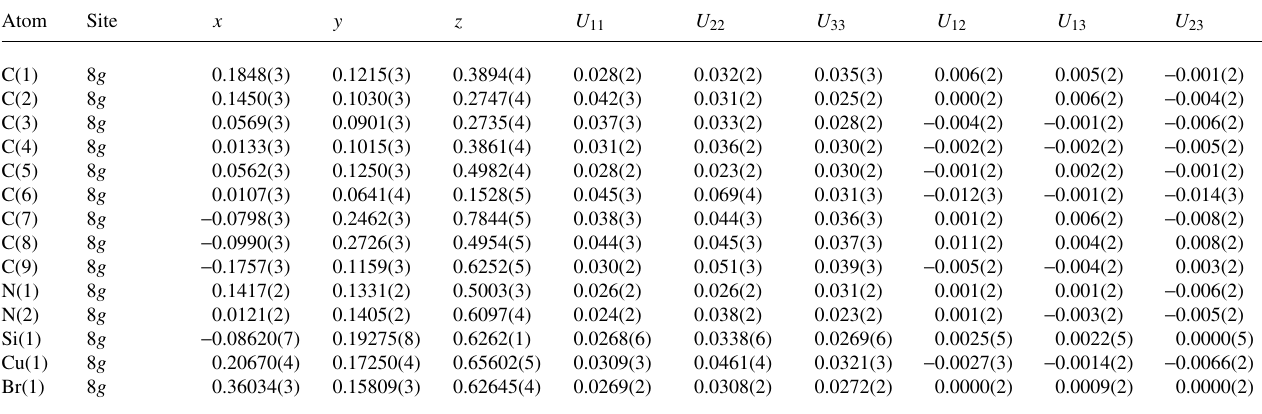
Table 3. Atomic coordinates and displacement parameters (in Å 2 )